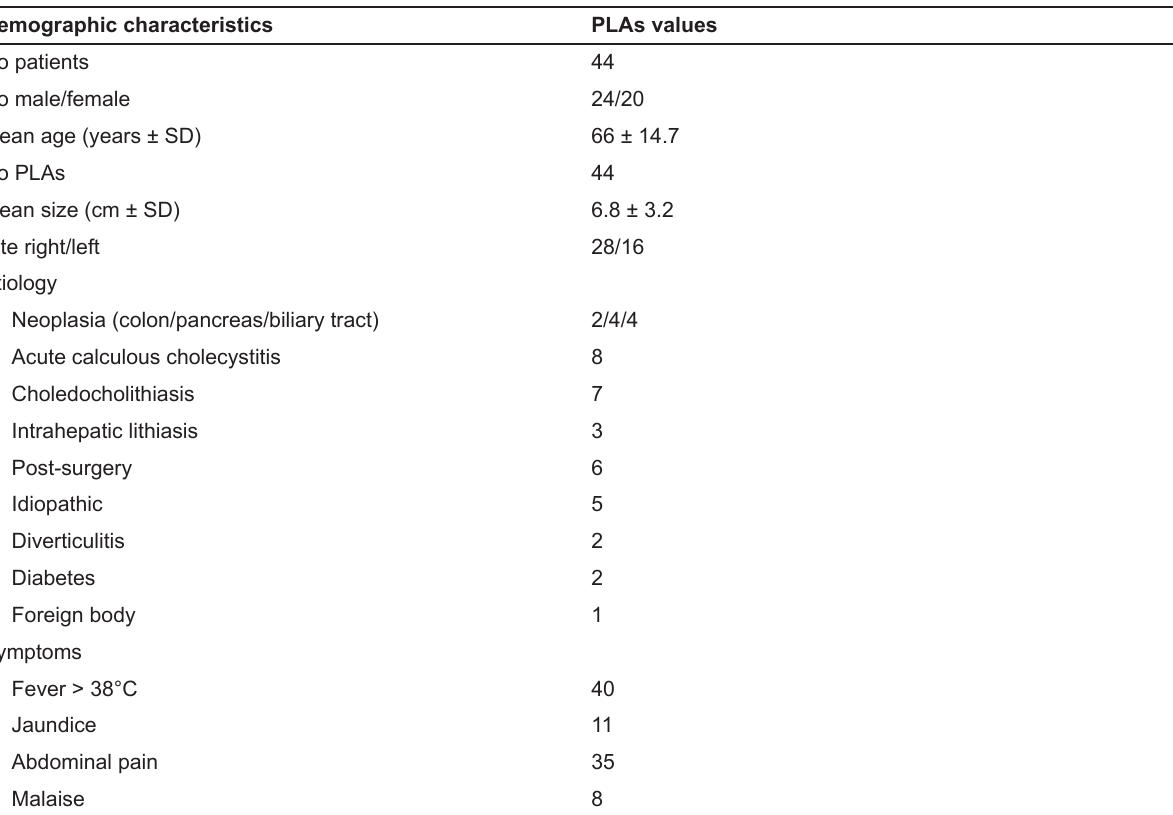
Table 1. Main characteristics of the PLAs studied with CEUS* Demographic characteristics PLAs